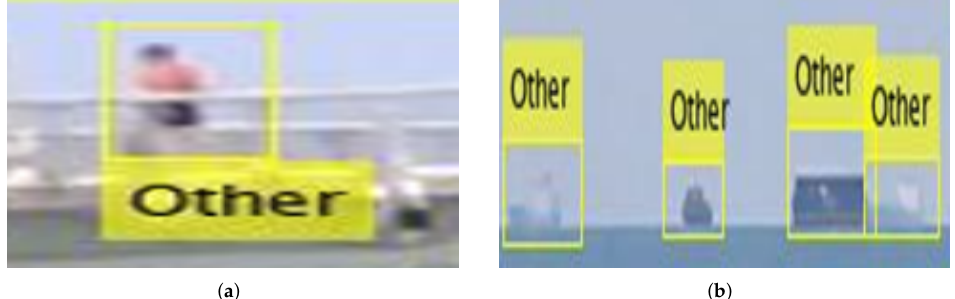
Figure 4. Examples of the ‘Other’ class in the SMD: ( a ) Deleted object from the ‘Other’ class, ( b ) Remained objects in the ‘Other’ class.